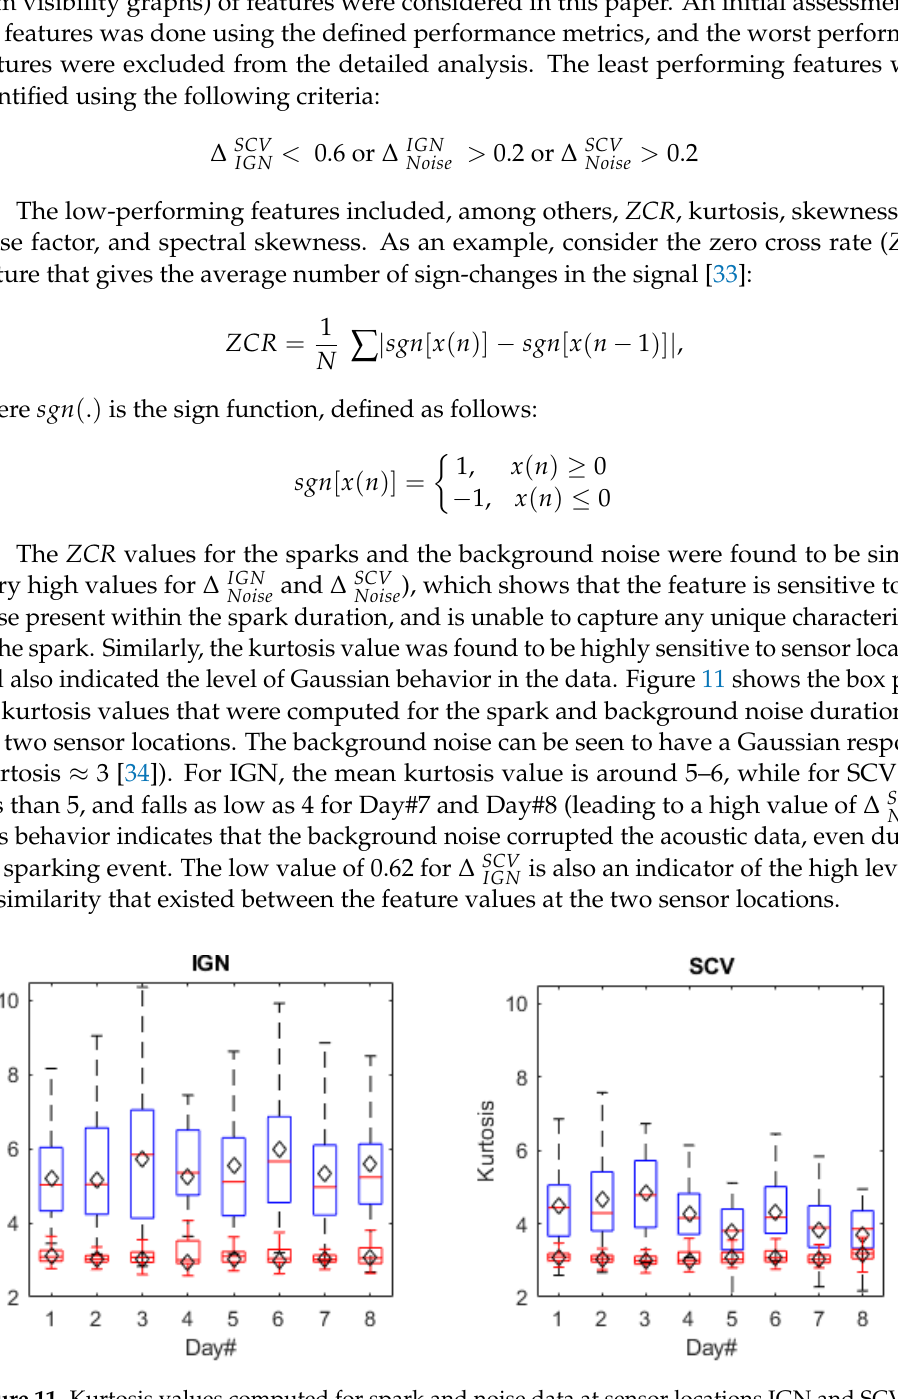
Figure 11. Kurtosis values computed for spark and noise data at sensor locations IGN and SCV.